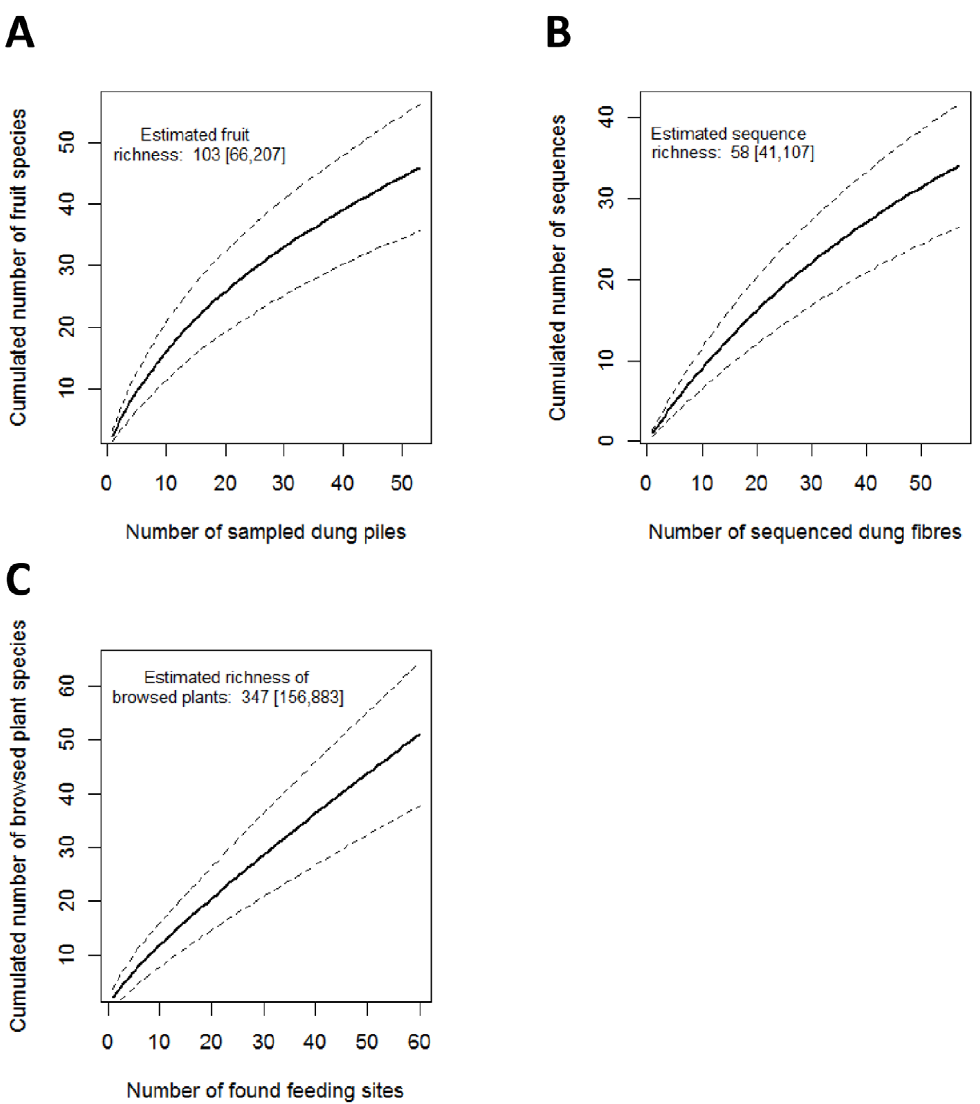
Figure 2. Species accumulation curves for plants eaten by tapirs in French Guiana from different sampling approaches . a) Cumulated richness of fruit residuals found in tapir dung samples, b) Cumulated richness of DNA sequences of individual fibres of browsed plants from 19 tapir dung piles, differing more than 5%, c) Cumulated richness of browsed plant species found in browsing signs. Total species richness is estimated by Chao2 estimators, with 95% confidence intervals given in square brackets.